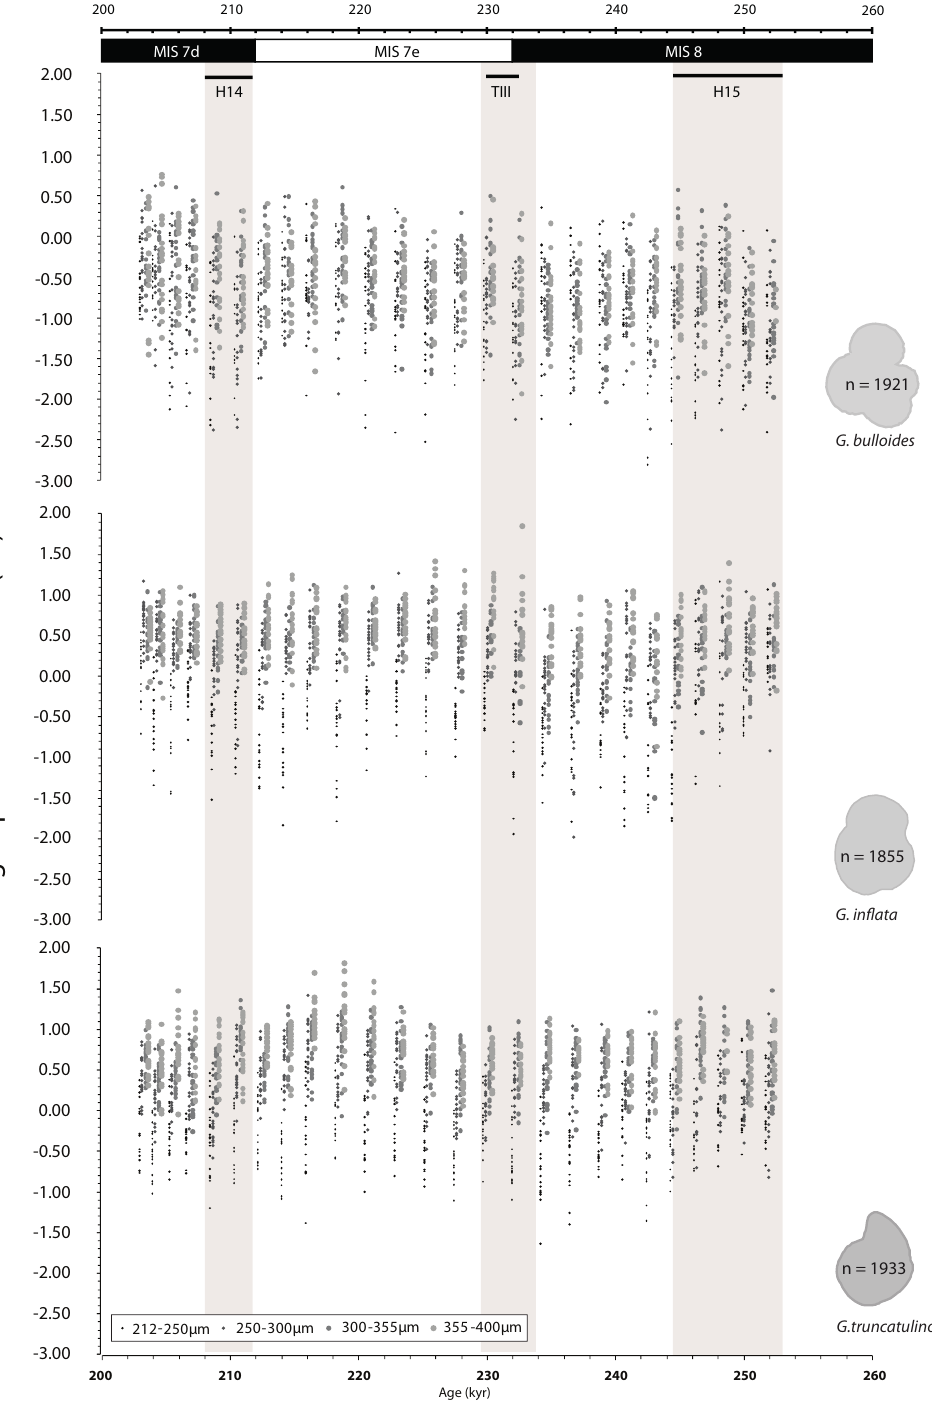
Figure 7. Single-specimen carbon isotope values. Raw δ 13 C values; symbol size denotes size fraction. For convenience, the data points are offset from one another. Highlighted regions represent the glacial and interglacial Heinrich events (H14 and H15) and Termination